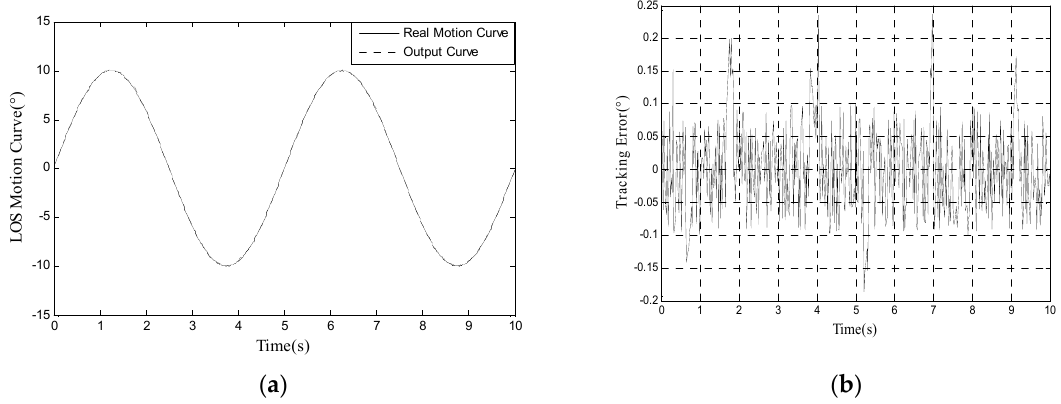
Figure 7. ( a ) LOS motion curve of our method when tracking 10° 0.2 Hz signal; and ( b ) tracking error of our method when tracking 10° 0.2 Hz signal.